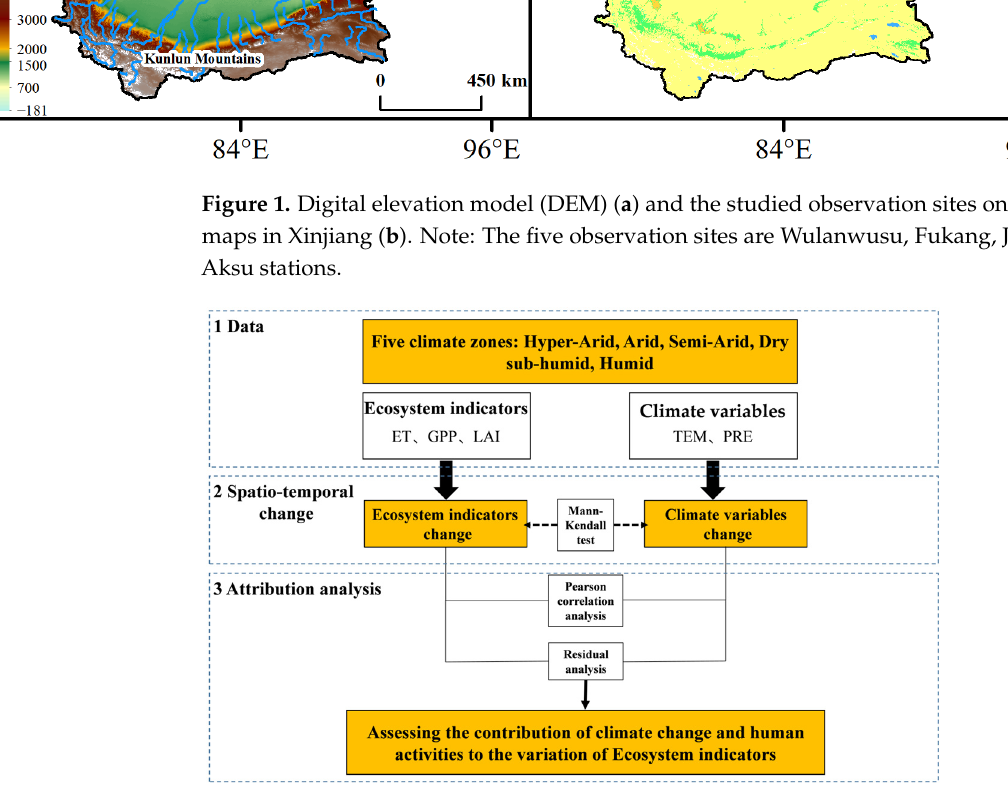
Figure 2. Technical flow chart.